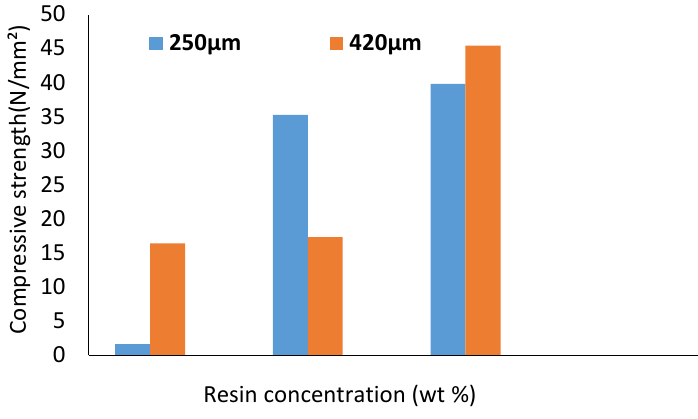
Figure 8 : The Specimens’ Compressive